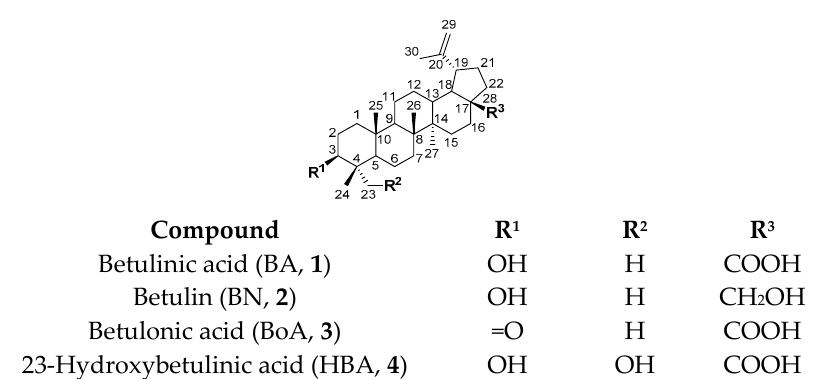
Figure 1. Structures and numbering system of betulinic acid (BA, 1 ), betulin (BN, 2 ), betulonic acid (BoA, 3 ), and 23-hydroxybetulinic acid (HBA, 4 ).